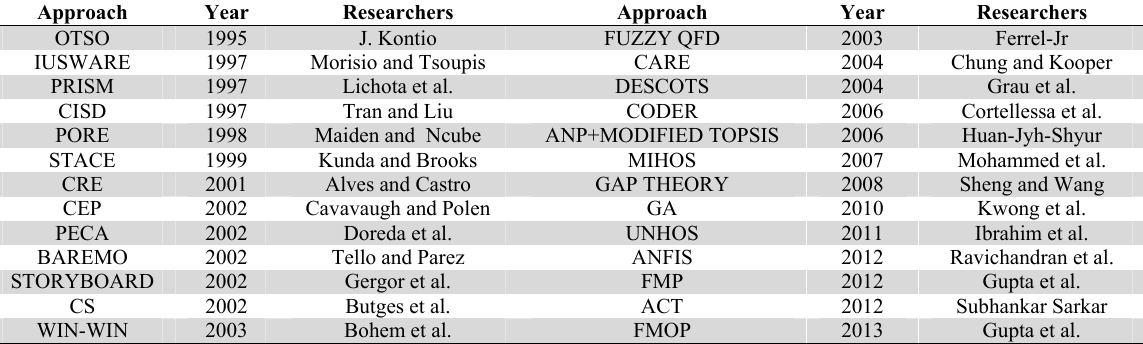
Existing COTS selection